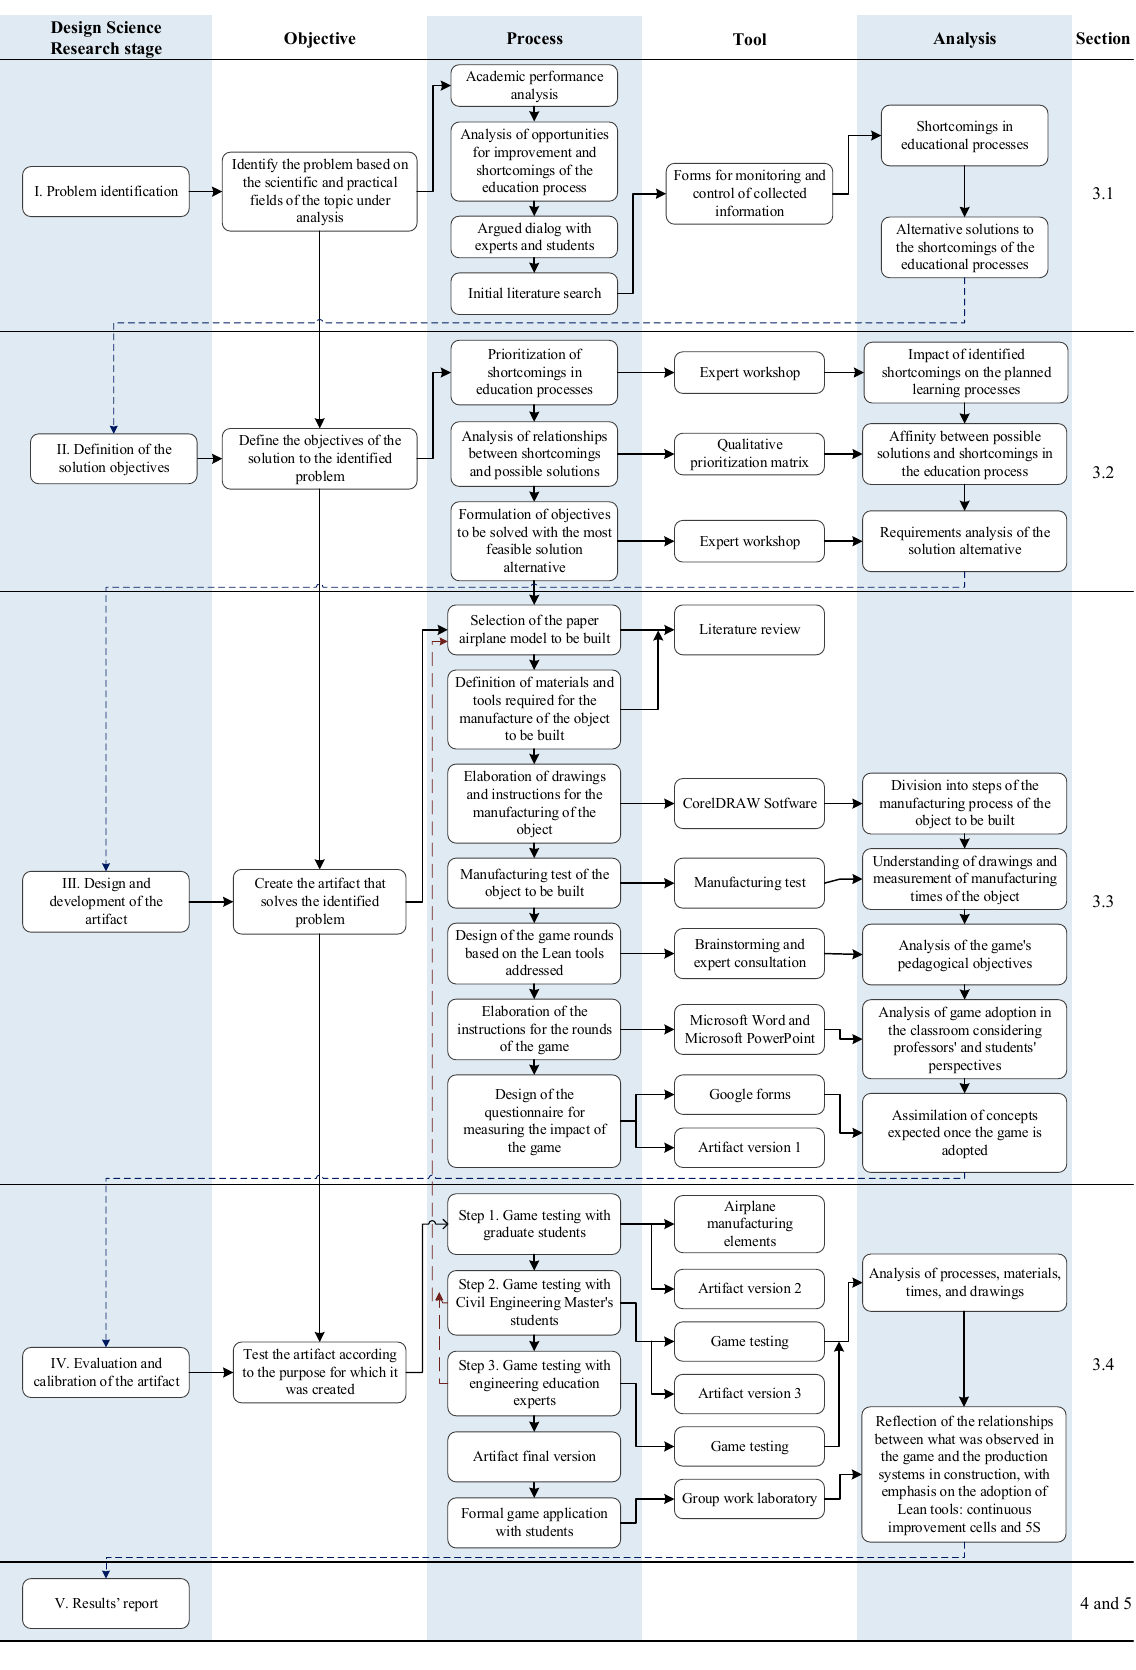
Figure 3. Methodological framework.